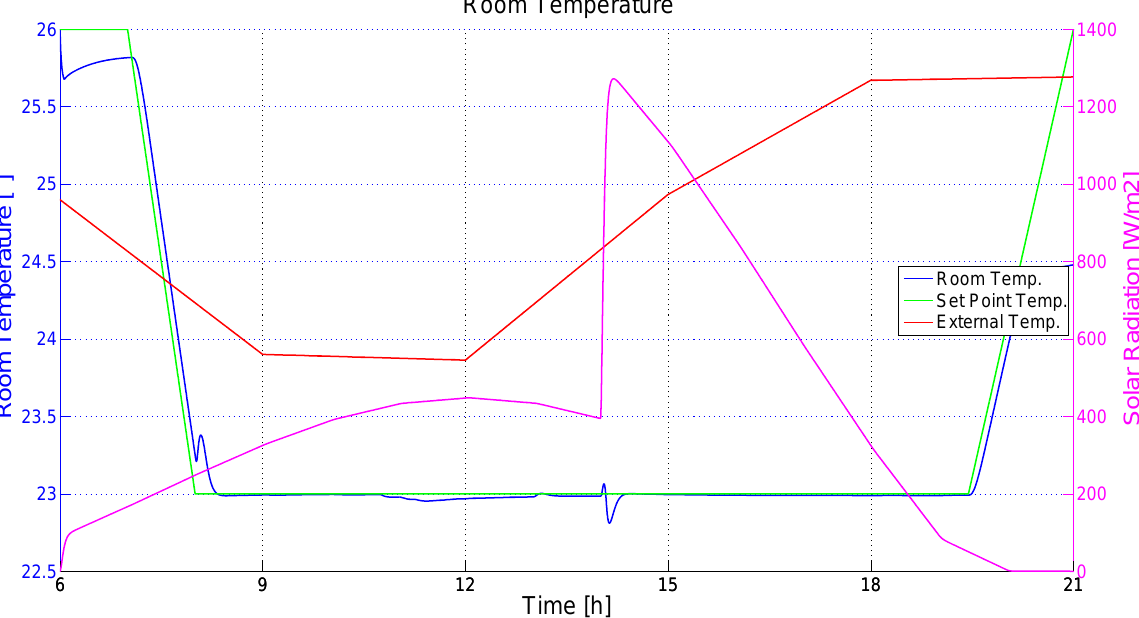
Figure 39. Control results (third scenario, modified control system, Energy Saving policy): room temperature (CV), outside temperature, and solar radiation (DVs).